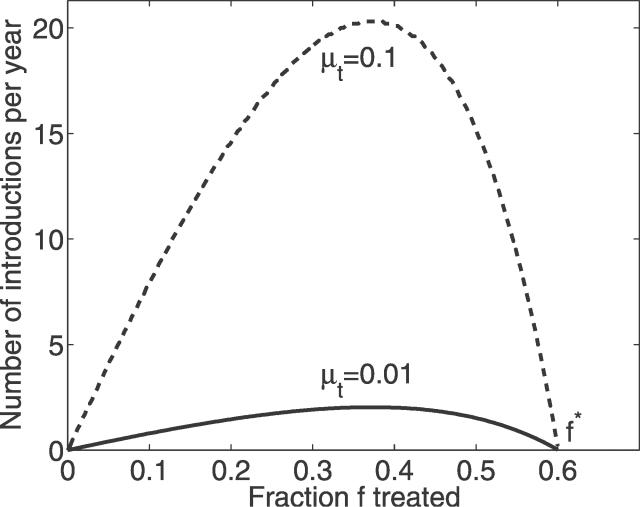
Number of Introductions Q = μt Ît per YearParameter choices are described in the text and in Table 1. Note that above a certain level of treatment, indicated by f*, the basic reproductive number for the sensitive strain is
, which makes the endemic steady state unsustainable and leads to disease extinction. In this study, we only consider the endemic situation with 0 ≤ f < f*.